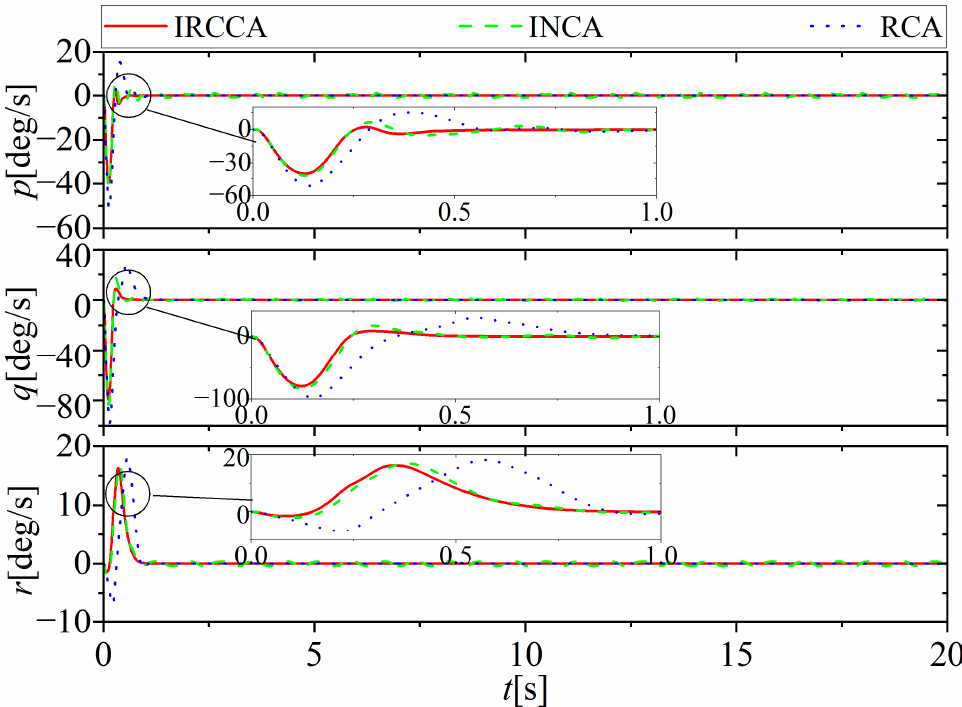
Figure 10. Time response of the attitude angle rate with loose fault.